Question: Produce a descriptive caption suitable for publication.
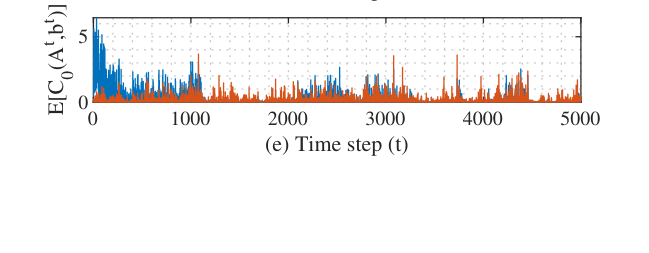
Answer: (d) shows the blocking cost of the two approaches. It shows that except for the time interval of 0 to 1000 steps, the blocking cost is almost the same for the two algorithms. In the initial 1000 time steps, Algorithm 1 has not converged yet.